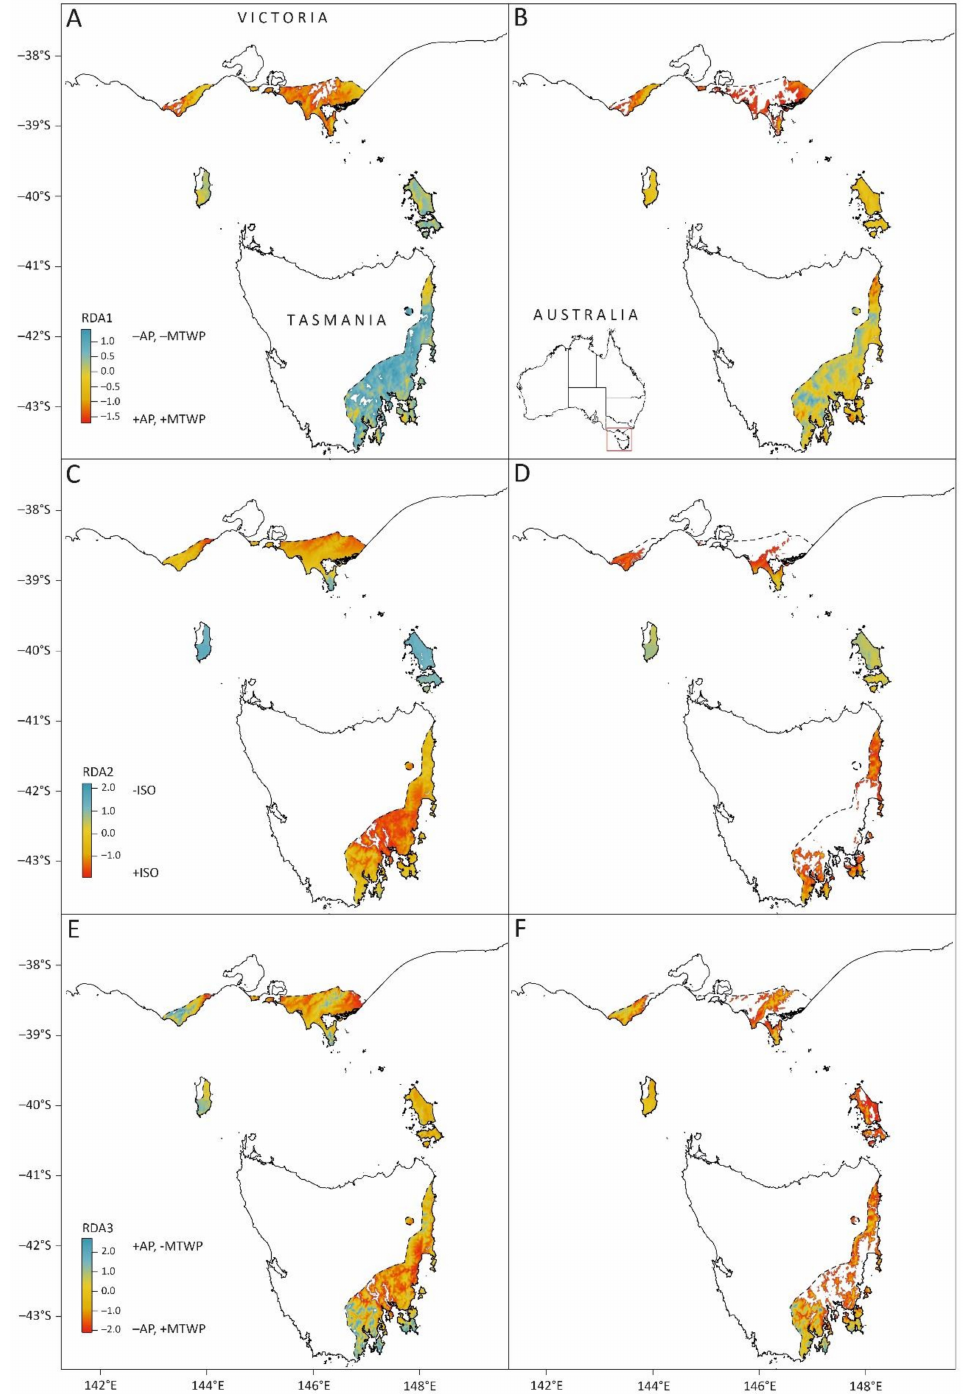
Figure 6. Maps of the contemporary (left—( A , C , E )) and projected 2070s (right—( B , D , F )) climate scaled to loadings of the Table S1. ( A , B ); RDA2: ( C , D ); RDA3: ( E , F )) are shown in Figure 5 and represent independent facets of the climate variation, which is associated with the identified set of climate-SNPs (i.e., SNPs indicated in blue in Figure